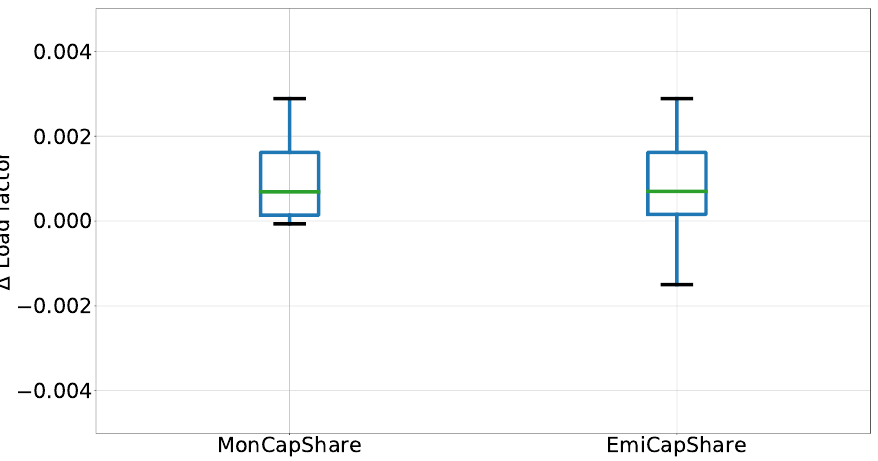
Figure 2. Deviation between CapShare scenarios and real world data for the load